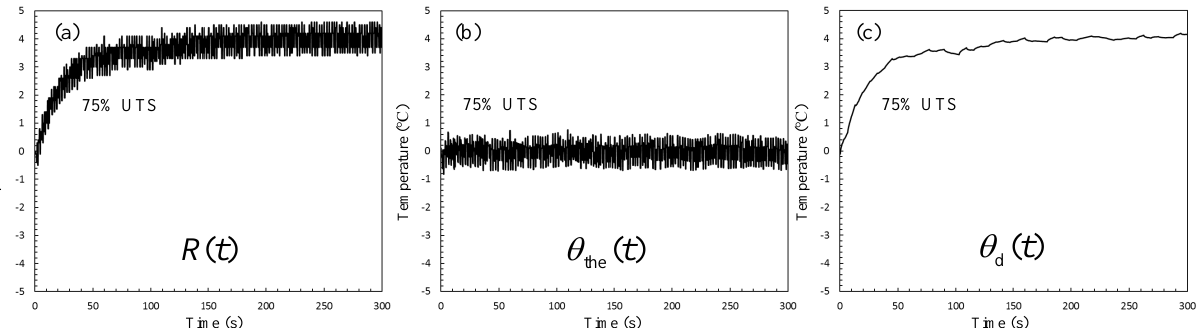
Figure 8. Separation of the thermoelastic coupling effect and energy dissipation effect for LPBF AlSi10Mg alloy un- der the stress level of 75% Ultimate Tension Stress (UTS). ( a ) Relative temperature increase acquired by the IR camera, ( b ) temperature variation caused by the thermoelastic coupling effect, and ( c ) temperature shift caused by the energy dissipation